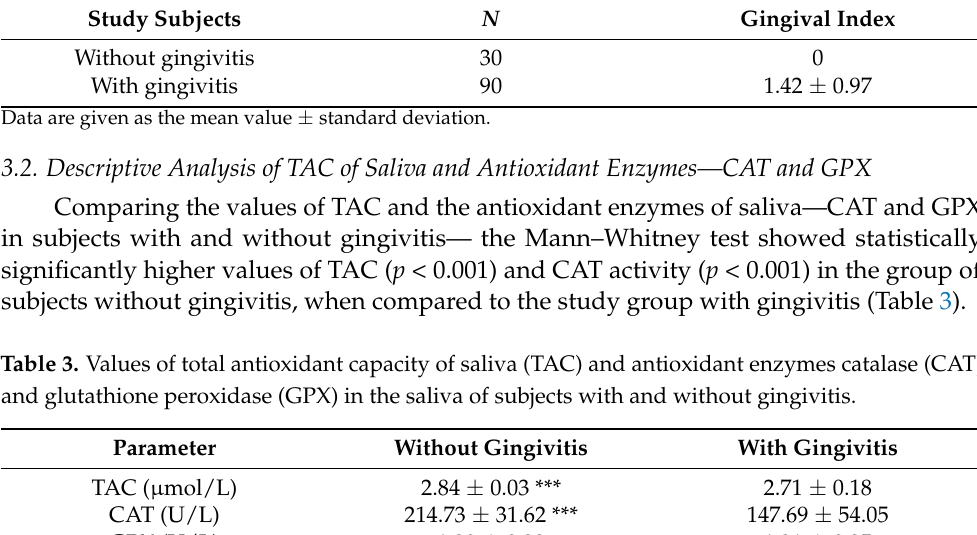
Table 4. Correlation of salivary total antioxidant capacity of saliva (TAC) and antioxidant enzymes catalase (CAT) and glutathione peroxidase (GPX) in the total study population. (cid:36) GPX TAC CAT 0.367 **